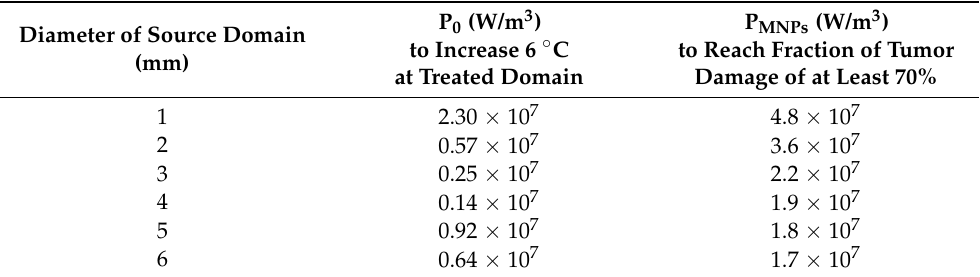
Table 1. Estimating the heating powers necessary for MNPs to reach fraction of tumor damage of at least